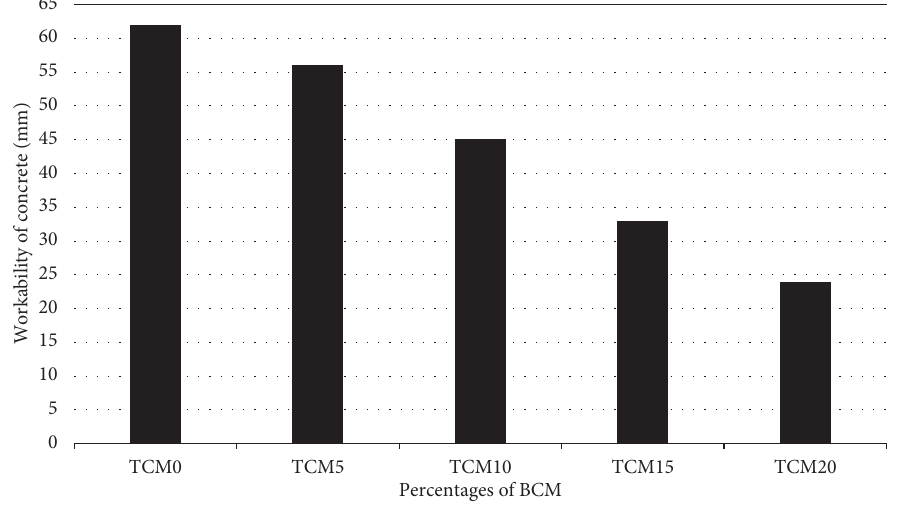
Figure 4: Slump test of green